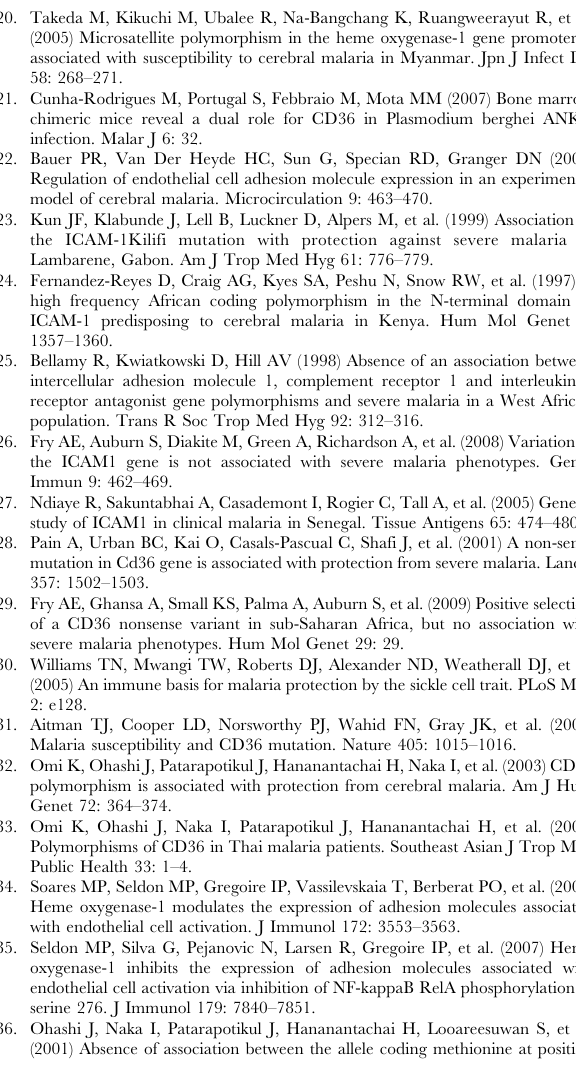
Table S1 Genotyped single nucleotide polymorphisms. Found at: doi:10.1371/journal.pone.0011141.s001 (0.08 MB Table S2 Allelic distribution of the HMOX1 GT repeat in distinct patient groups and uninfected controls.